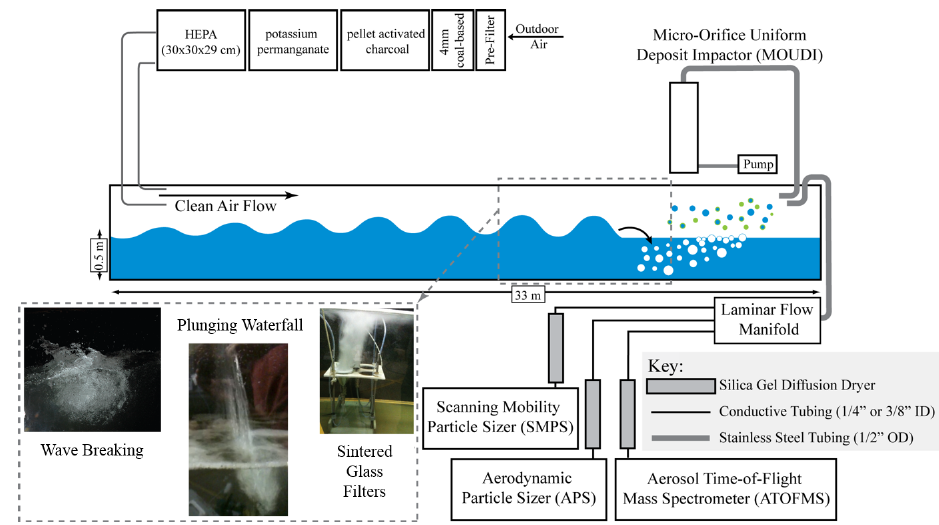
Figure 1. Schematic of the linear wave channel with interchangeable bubble generation apparatuses for SSA production. Each of these bubble generation mechanisms were tested within the wave channel within 24 hours, and with the same natural seawater